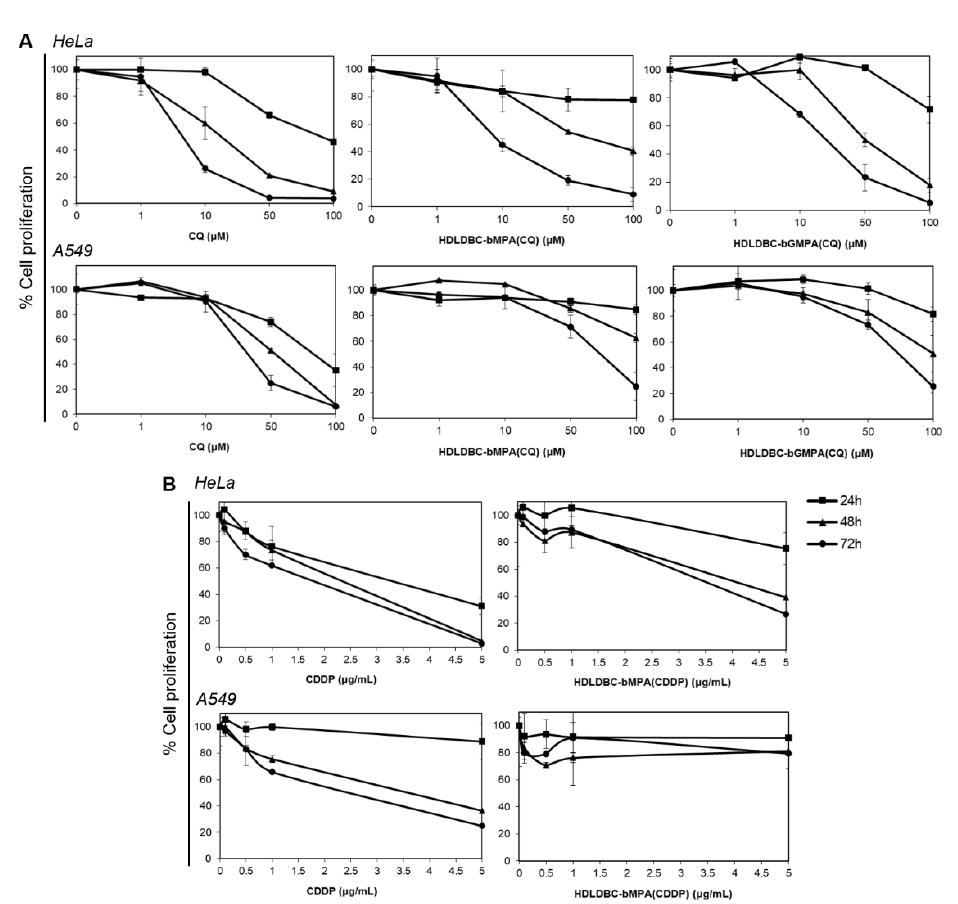
Figure 4. Effect of ( A ) CQ and ( B ) CDDP free or encapsulated on HDLDBC-bMPA or HDLDBC-bGMPA on the proliferative activity of Hela cells and A549 cells at 24 h, 48 h and 72 h determined by the AlamarBlue assay. The y-axis represents the proliferation rate, calculated as the ratio to control untreated cells at each time point. The CQ and CDDP-induced inhibitory effect was time and dose-dependent. Values are given as mean ± SD ( n = 3).